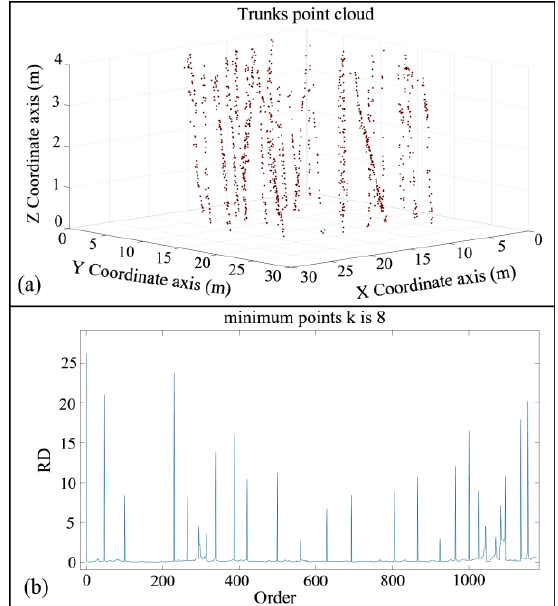
Figure 4. Trunks point cloud of half of trees of Plot 1 and (b) output of OPTICs algorithm that was carried out on this point